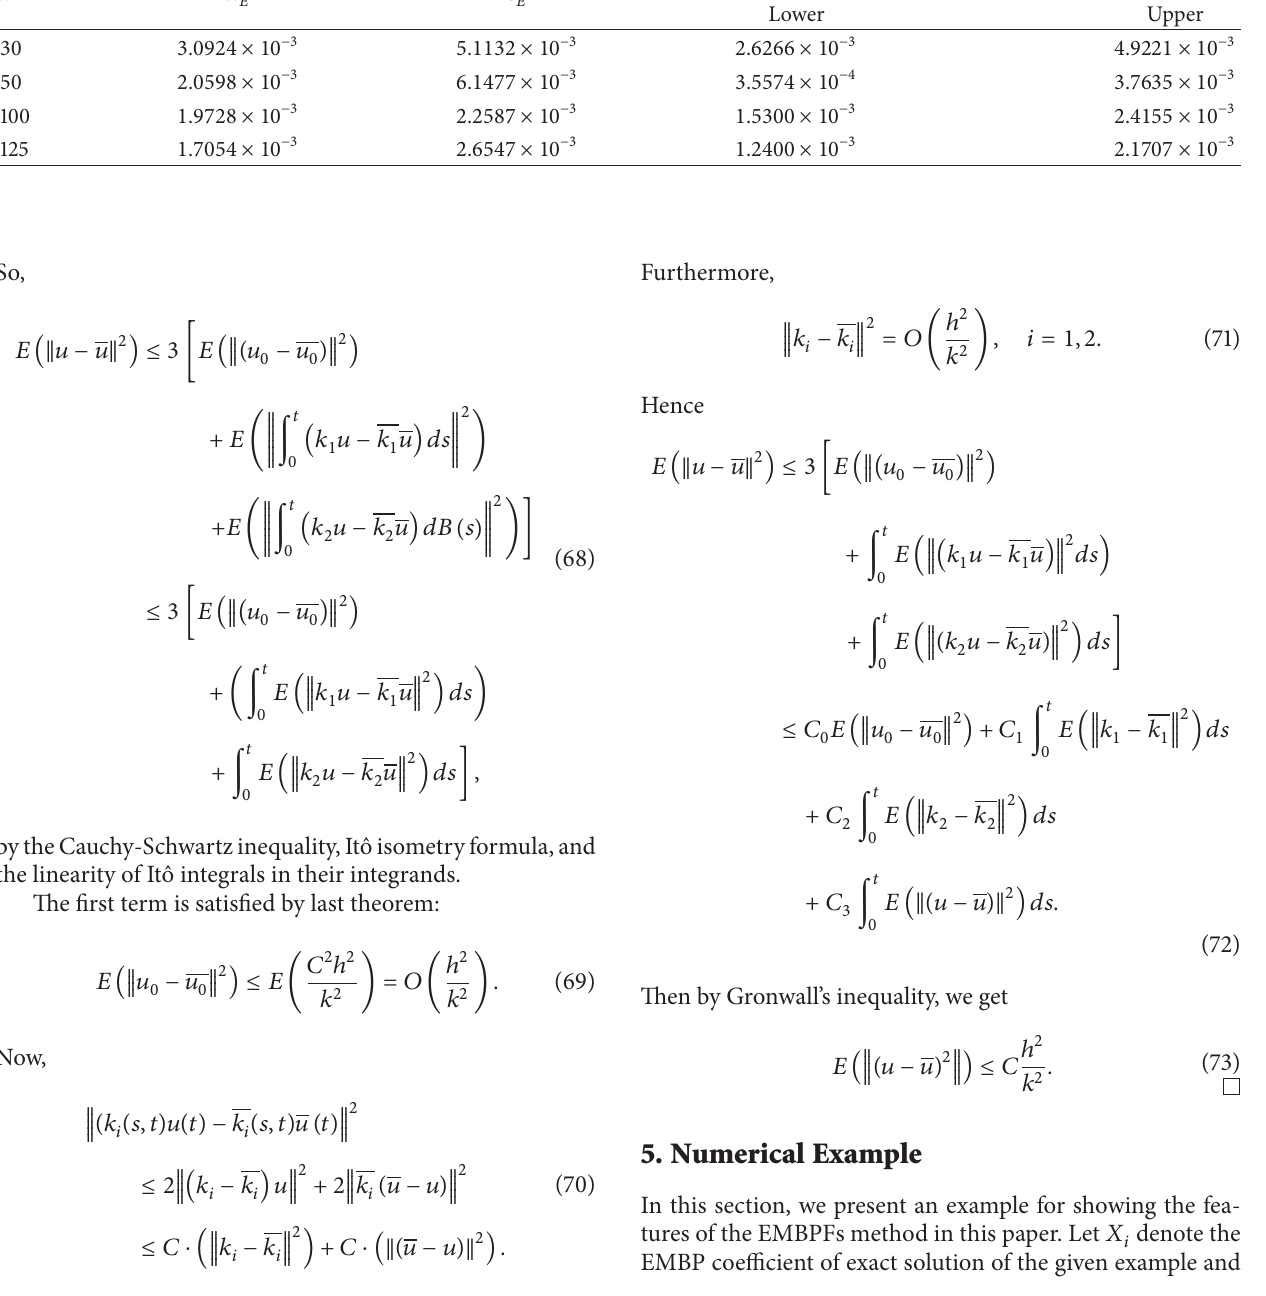
Table 2: Mean, standard deviation, and confidence interval for error mean in Example 1 with 𝑚 = 8 , 𝑘 = 4 .